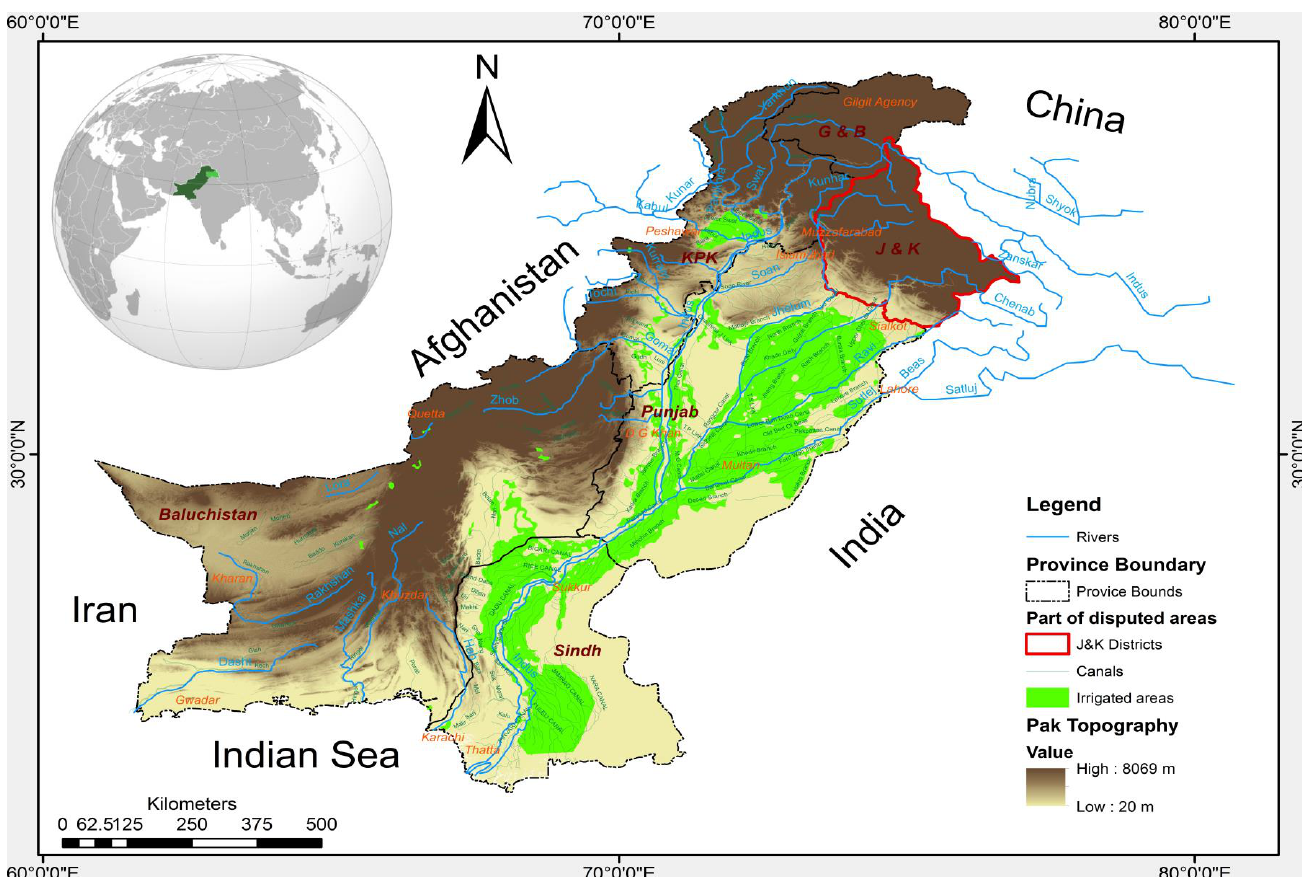
Figure 2. Details of surface water resources of Pakistan in regional and international context (this map was developed by the author from the DEM taken from the USGS HydroSHEDS Available online: https://hydrosheds.cr.usgs.gov/notes.php (accessed on 16 June 2019, and further processing/ digitization of free maps of Pakistan.).